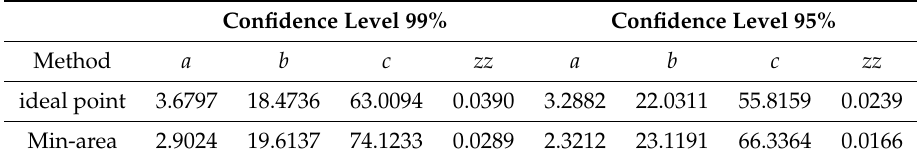
Table 8. n = 39 (confidence level 99% and 95%).